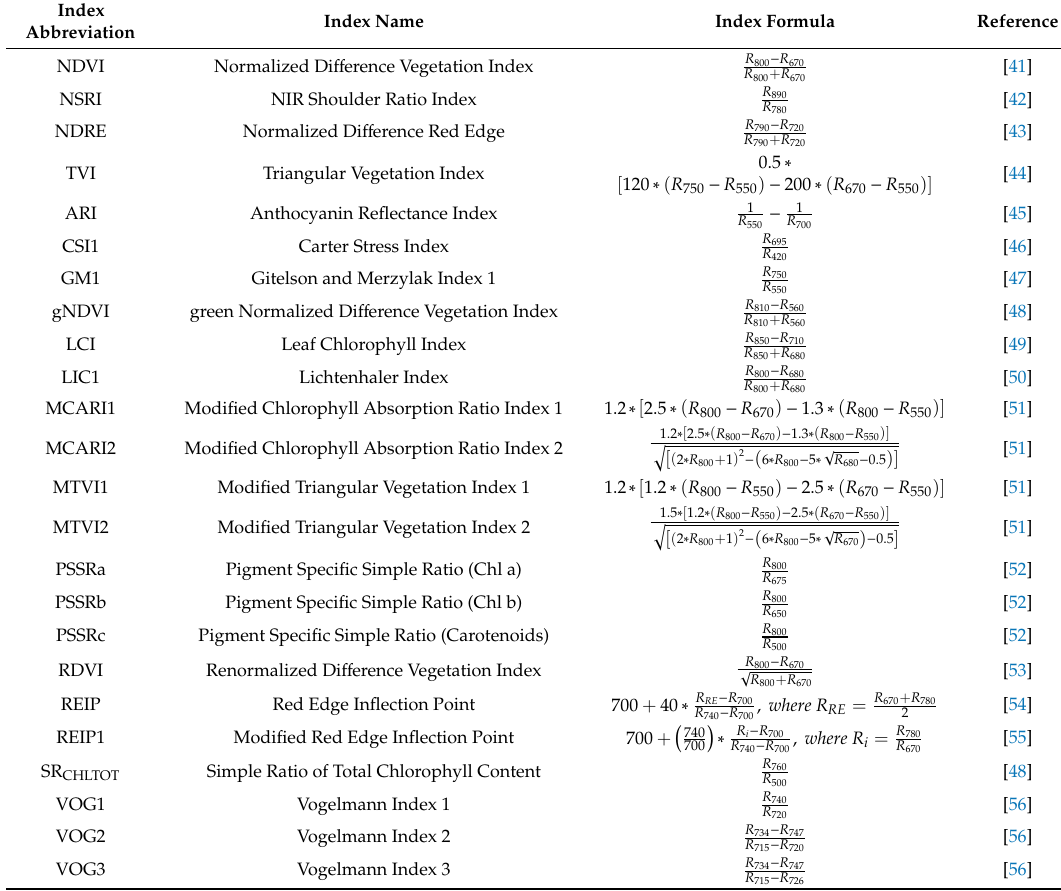
Table 1. Spectral vegetation indices that were used for feature selection in this